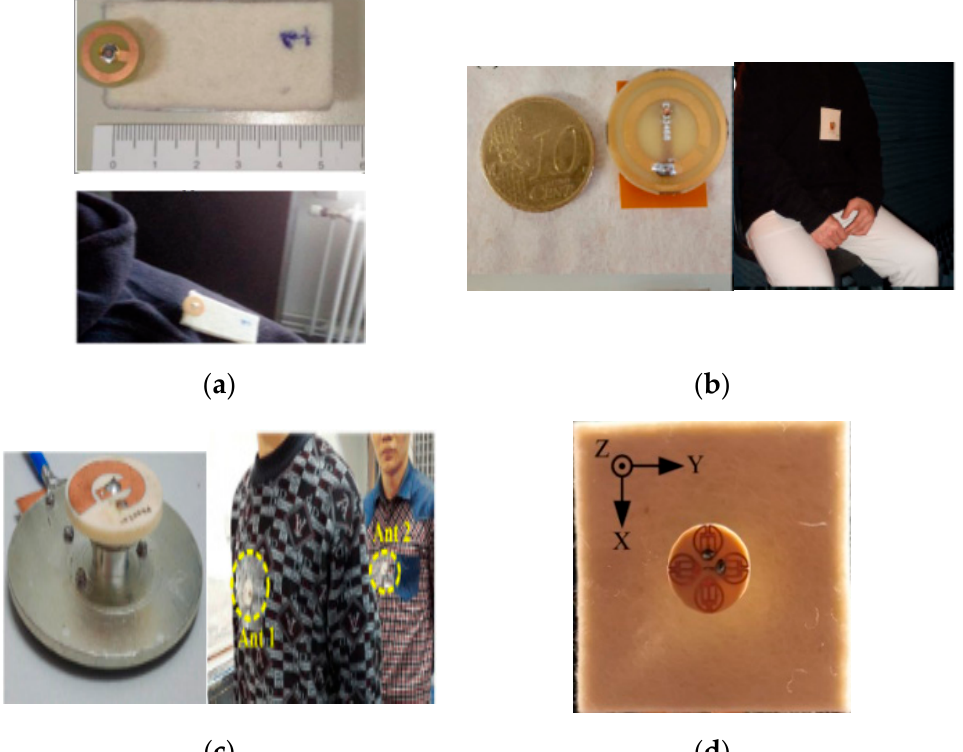
Figure 9. ( a ) Wideband button [275], ( b ) circularly-polarized button [276], ( c ) F-inverted button [279], and ( d ) array button antenna [280].